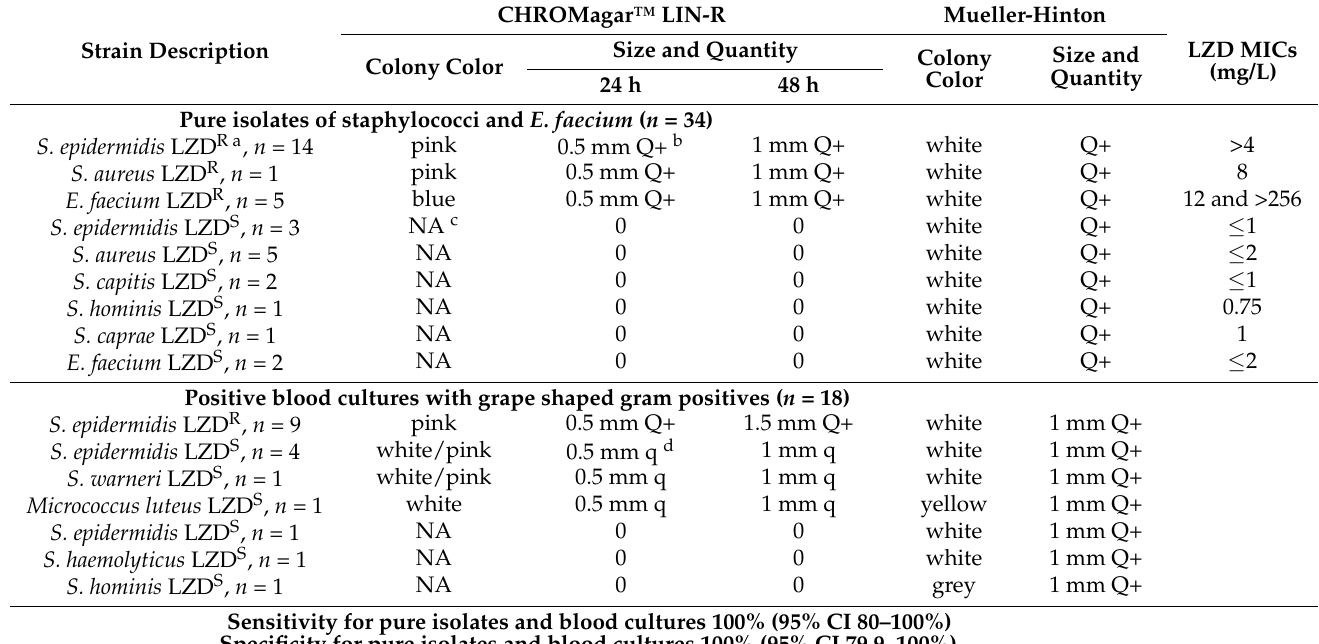
Table 1. Performances of CHROMagar™ LIN-R on pure isolates and on blood cultures of staphylo- cocci and E. faecium isolates with 24 h and 48 h